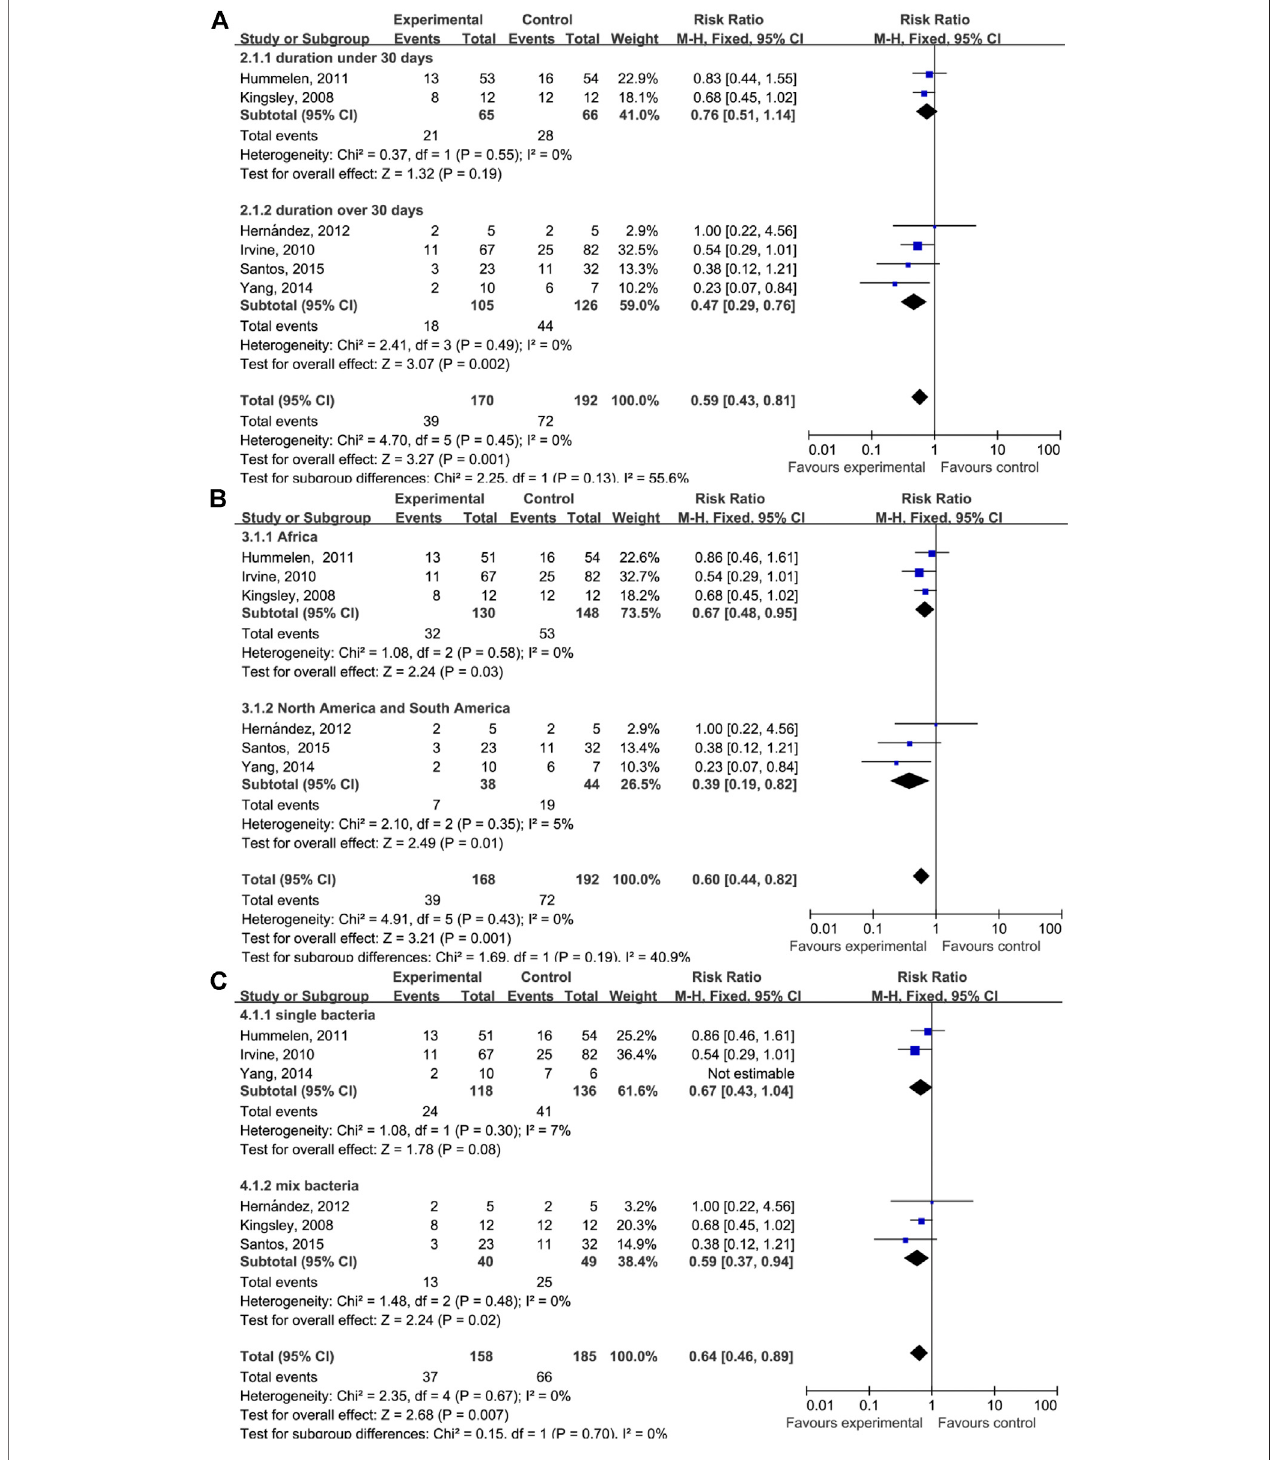
FIGURE 4 | Forest plot analyses of different factors. (A) Forest plots for the dosing time of taking probiotics. (B) Forest plots for different geographical factors of study subjects. (C) Forest plots for single or mixed probiotics of study subjects.